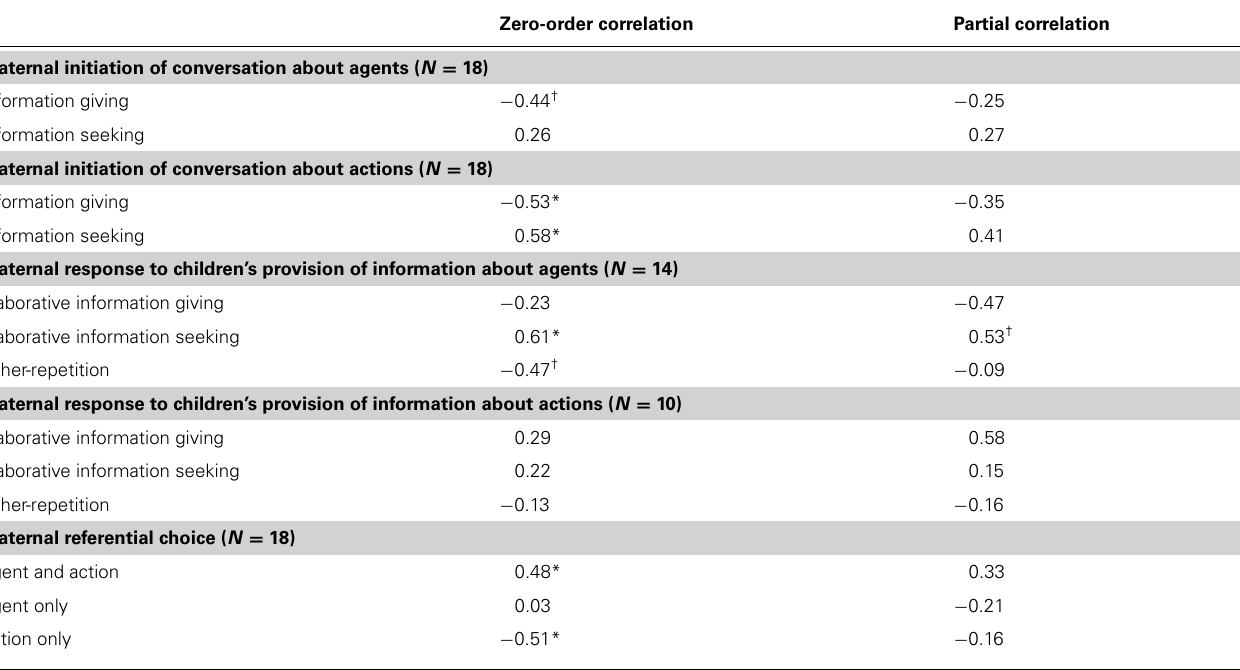
Table 3 | Zero-order and partial correlations between maternal conversational styles when children were 20 months of age and children’s observed productive vocabulary size at 27